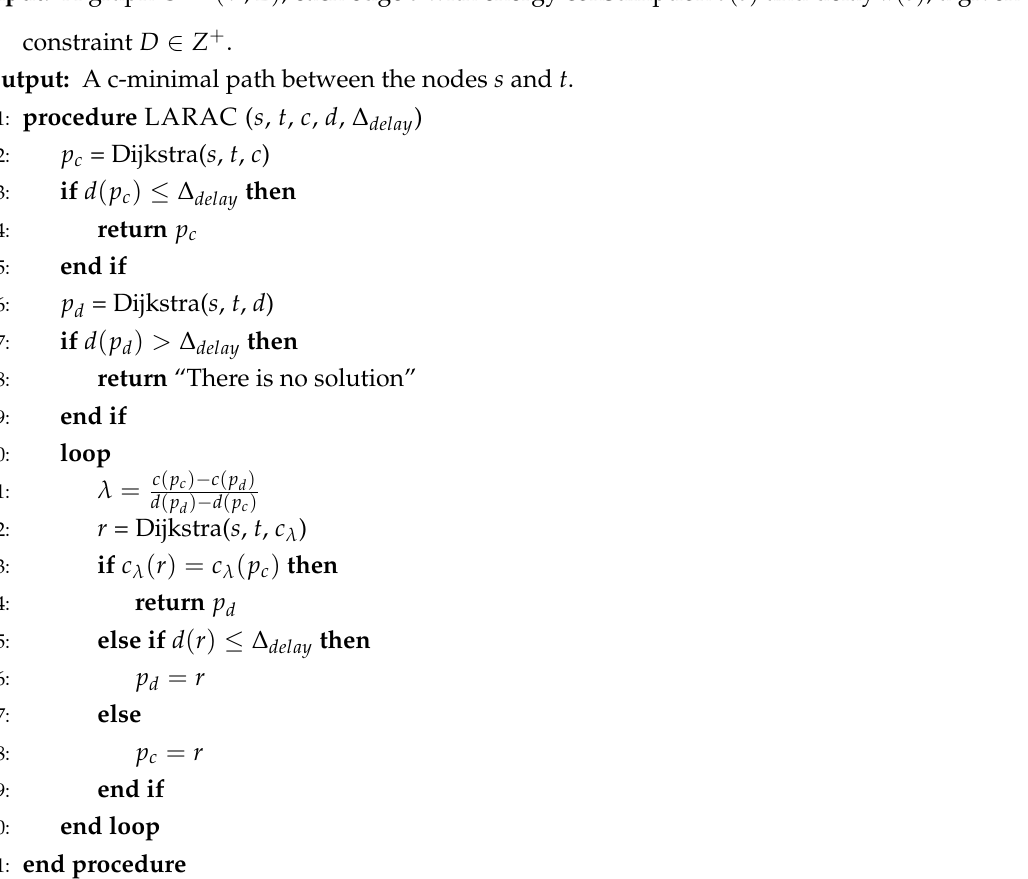
Algorithm 2 Lagrange Relaxation based Aggregated